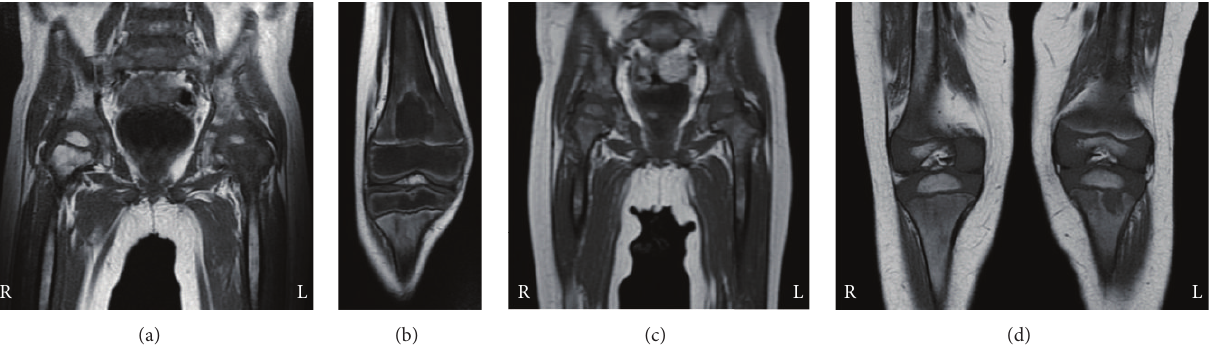
Figure 5: MRI findings after the remission induction chemotherapy. Bone marrow in all cases contains increased signal intensity on T1- weighted images. (a) Case 1, (b) case 2, (c) case 3, and (d) case